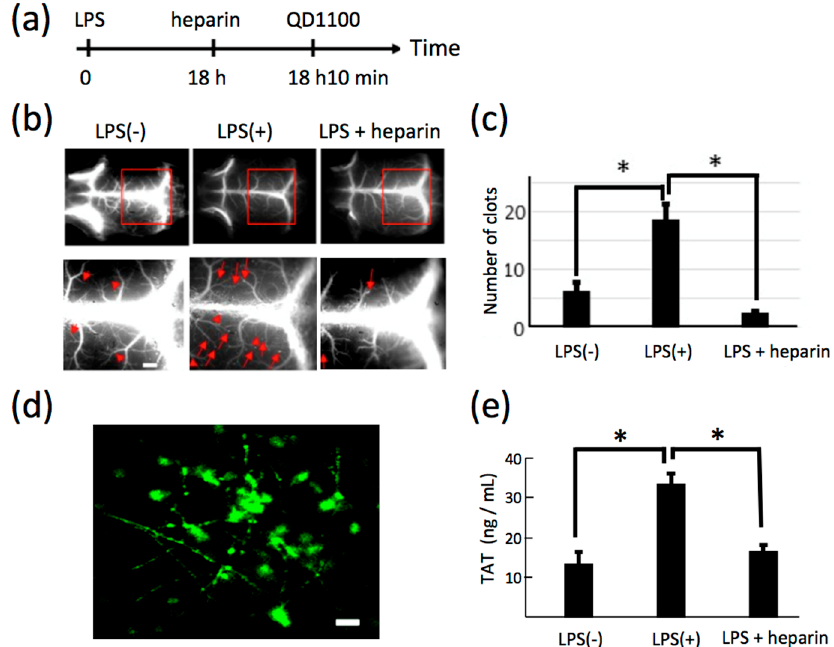
Figure 6. ( a ) Time course of experimental procedure for lipopolysaccharide (LPS) and heparin administration; ( b ) NIR fluorescence images (>1000 nm) of cerebral blood vessels before and after administration of LPS (LPS( − ) and LPS(+)), and the image following additional administration of heparin (LPS + heparin), with scalp removed. Lower panel shows the magnification of the images shown by red rectangles. Red arrowheads show clots. Scale bars: 1 mm; ( c ) Statistical analyses of the clots in the cerebral vessels. *: p < 0.05, number of mice: LPS( − ): n = 5, LPS (+): n = 5, LPS + heparin: n = 3; ( d ) Immunofluorescence staining of LPS-treated cerebral blood vessels, where anti-fibrinogen antibody (Alexa Fluor 488) was used for staining of fibrinogen. Fibrinogen helps the formation of blood clots. Scale bar: 10 μ m; ( e ) ELISA assays for thrombin–antithrombin complex (TAT) in blood plasma. *: p < 0.05, number of mice: LPS( − ): n = 5, LPS(+): n = 5, LPS + heparin: n = 3.